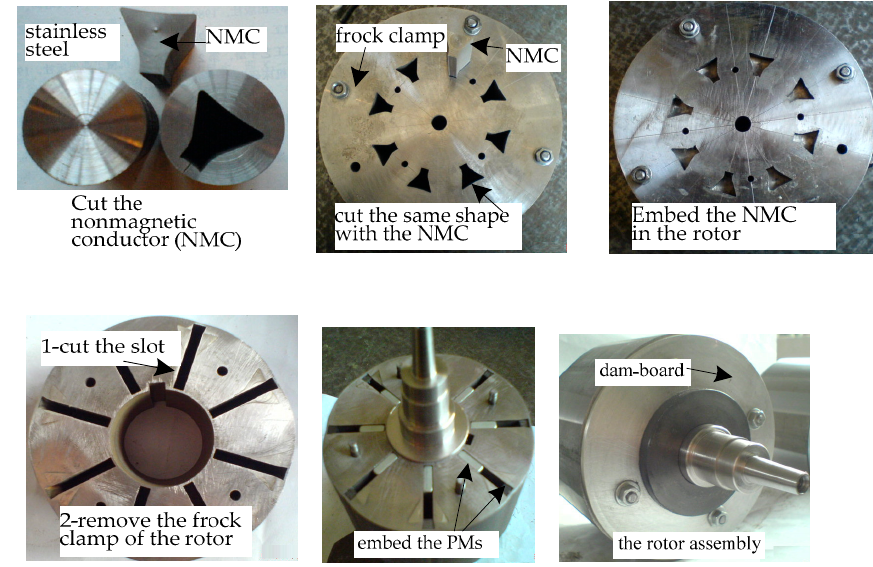
Figure 22. The prototype of the non-magnetic conductor and the rotor.